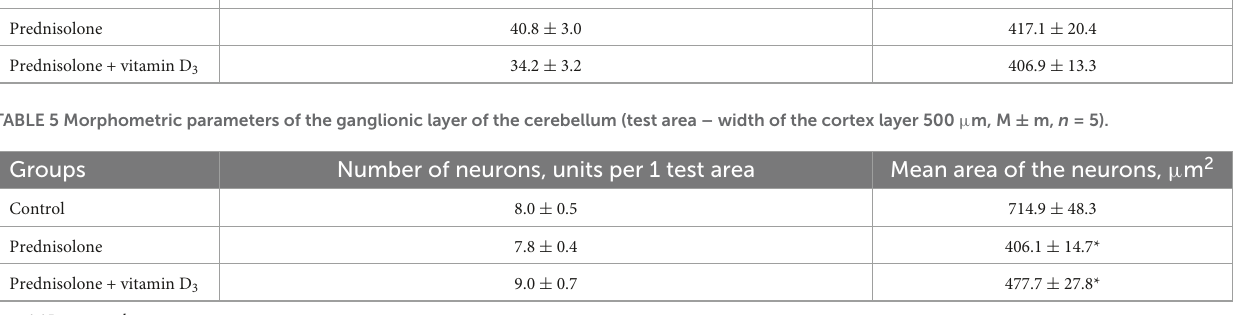
TABLE 4 Morphometric parameters of the thalamus (posterior thalamic nucleus, test area 550 µ m × 215 µ m, M ± m, n = 5). Groups